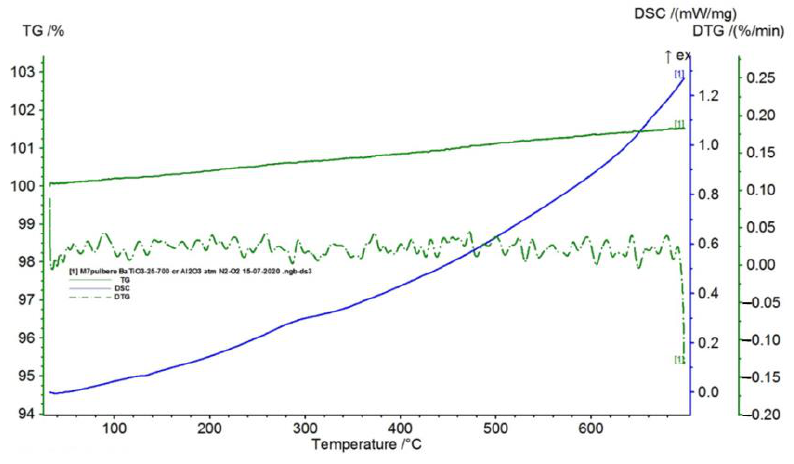
Figure 3. TG/DSC curves registered for TPU.